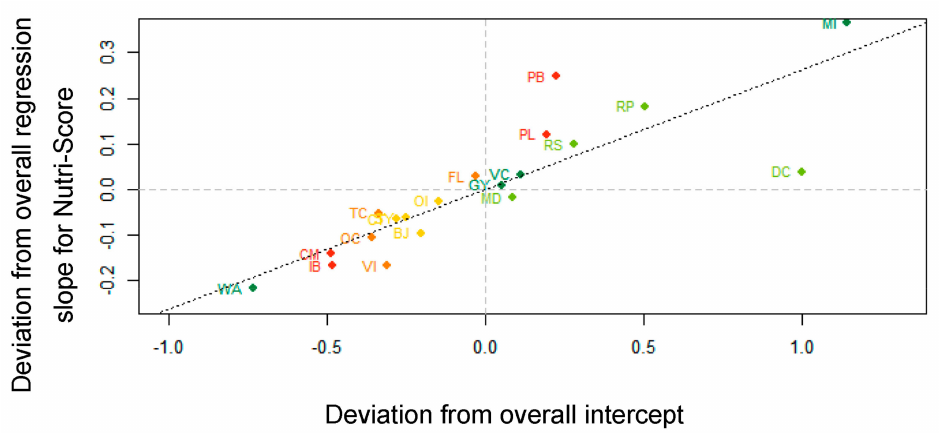
Figure 5. Correlation ( r = 0.82) between by-stimulus deviations from overall intercept and by- stimulus deviations from overall regression slope for Nutri-Score. Abbreviations of the product names are explained in Figure 4 and in Appendix A (Table